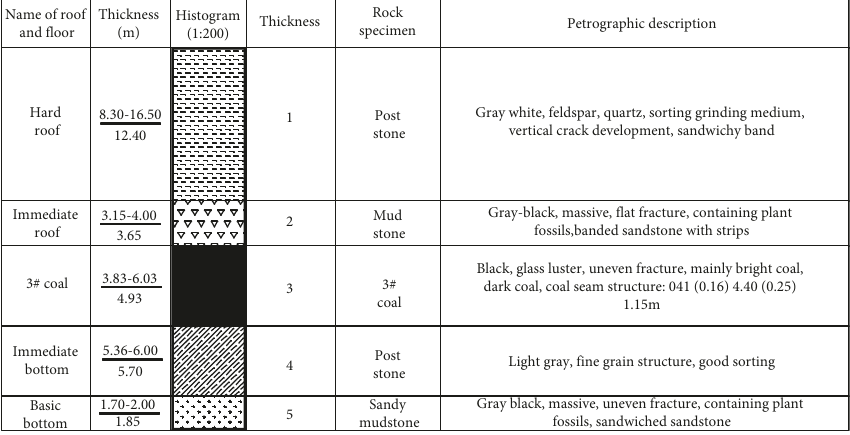
Figure 1: Lithologic histogram of roof and floor of coal seam. Table 1: Mechanical parameters of coal and rock in transport and